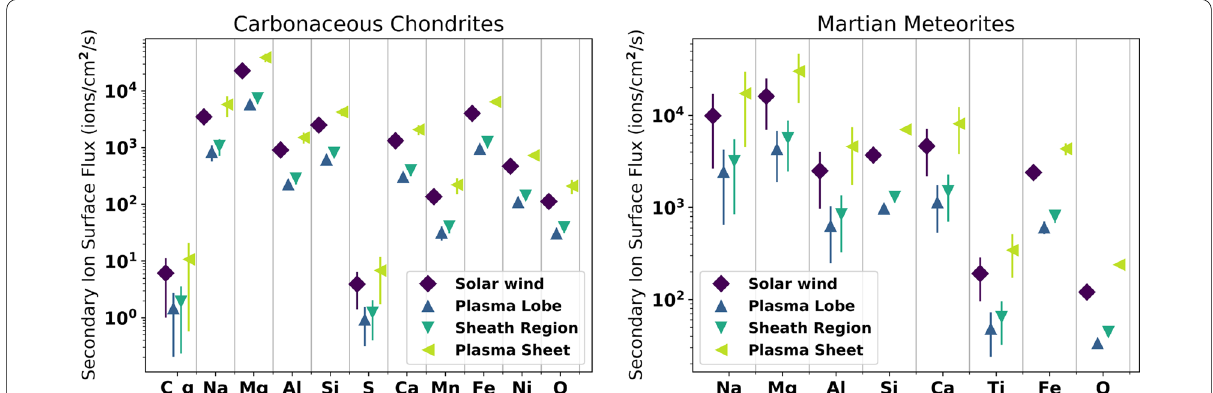
Fig. 1 Secondary ion ratios for several types of meteorites considering the solar wind and Martian magnetospheric ion sputtering. Solar wind fluxes were calculated assuming 95% H + and 5% He ++ ions, and incident ion fluxes for the various magnetosphere regions were determined from MAVEN STATIC observations combined with SDTrimSP sputtering simulations and experimental calibration of relative secondary ion yields (Schaible et al.